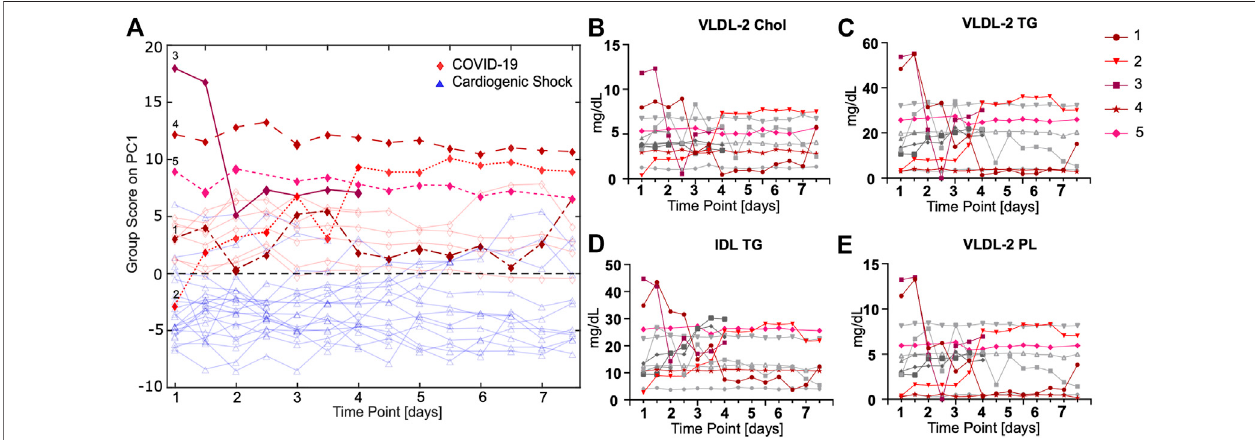
FIGURE 5 | (A) ASCA analysis of COVID-19 (red) vs. CS (blue) samples shows a separation between groups in consideration of different groups and time points. (B – E) Time courses oflipoproteins measured twice aday for COVID-19 patients thatare only signi fi cant forcomparison ofCOVID-19 vs. CS show striking progressions over time for some patients (highlighted in